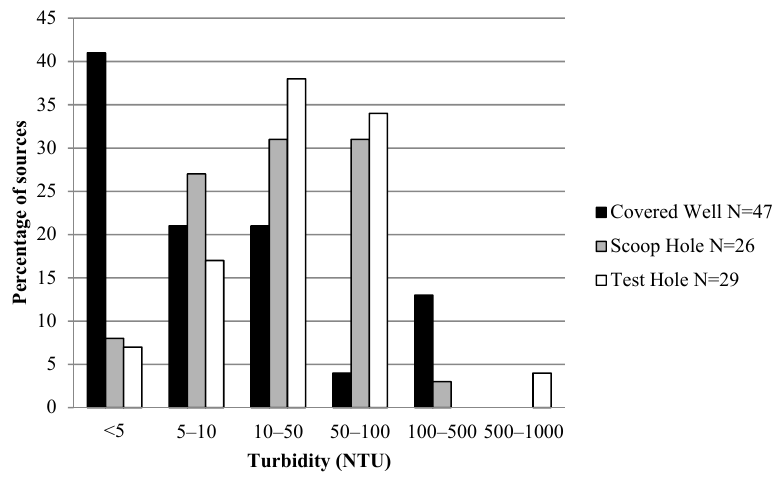
( p < 0.04 and <0.01 respectively). This is due to the method the Kruskal-Wallis test uses of ranking the sources by